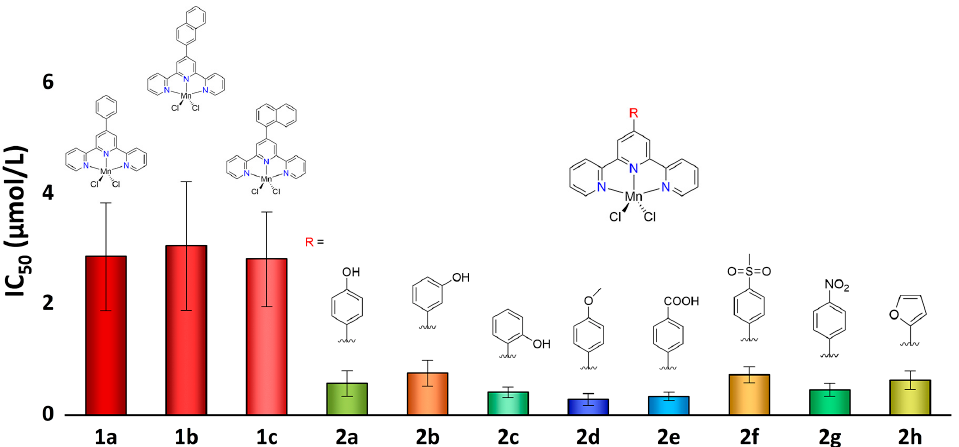
Figure 6. IC 50 values ( µ M) of compounds 1a – 1c and 2a – 2h against the A549 cell line and the structures of the compounds.